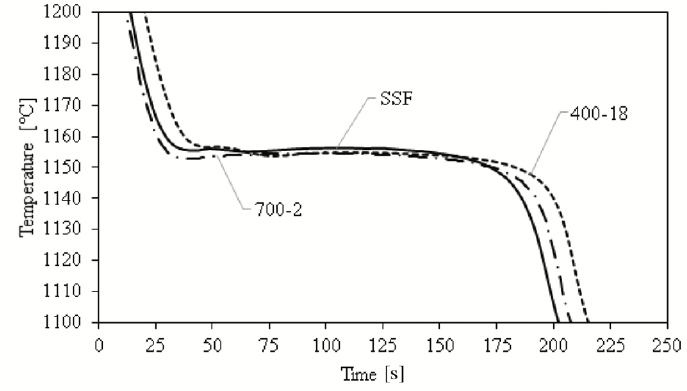
Figure 4. Comparison of temperature profile during the eutectic transformation between traditional and solution strengthened ferritic ductile iron.